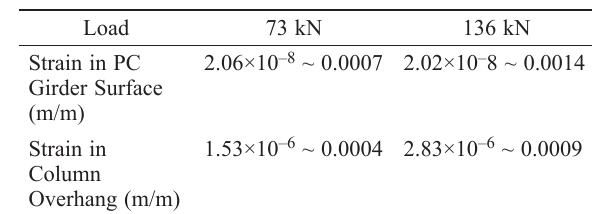
Table 5. Strains in PC Girder-Column Interface